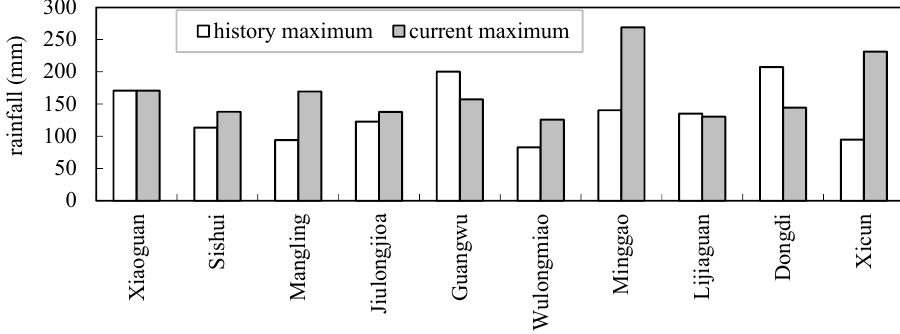
Figure 5. The maximum 6 h rainfall of ten reference stations between historical and “7.20” rain- storms.